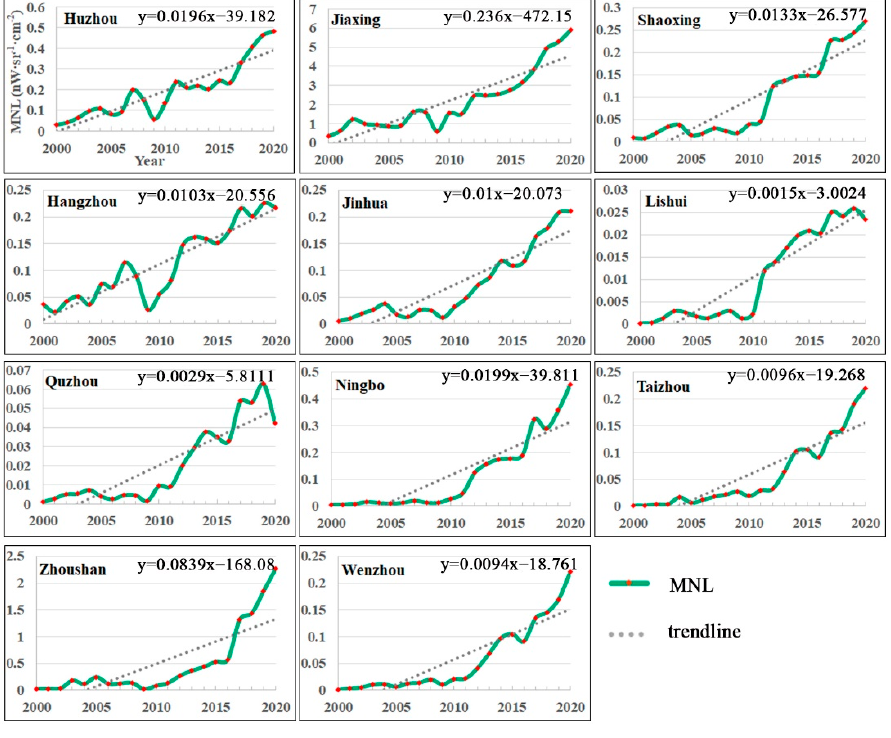
Figure 4. MNL within the ECR of Zhejiang Province from 2000 to 2020.